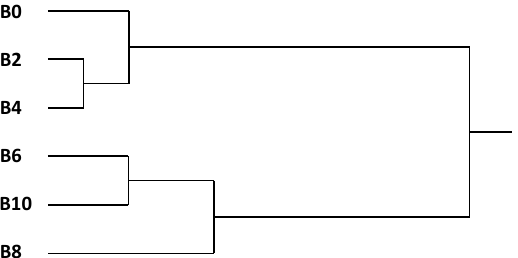
Figure 4. Cluster analysis (average linkage method) applied on data reported in Table 4. A clear split into two clusters (B0–B2–B4 vs. B6–B8–B10) is shown. Moreover, a closer “friendship” between B6 and B10 rather than B8 and B10 can be observed. This particular behavior suggests a